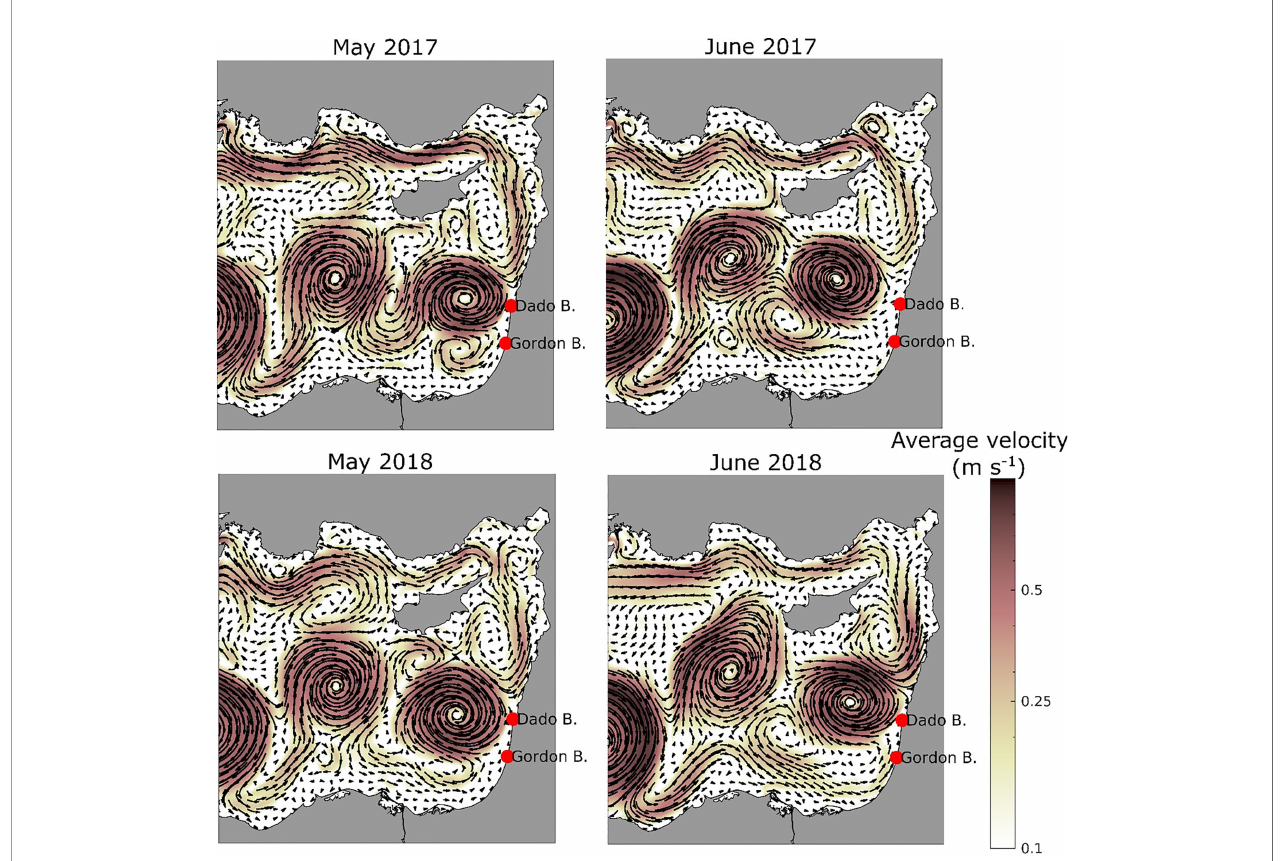
FIGURE 4 | Monthly average surface current velocity and direction used in the particle model for May (left) and June (right) in 2017 (top) and 2018